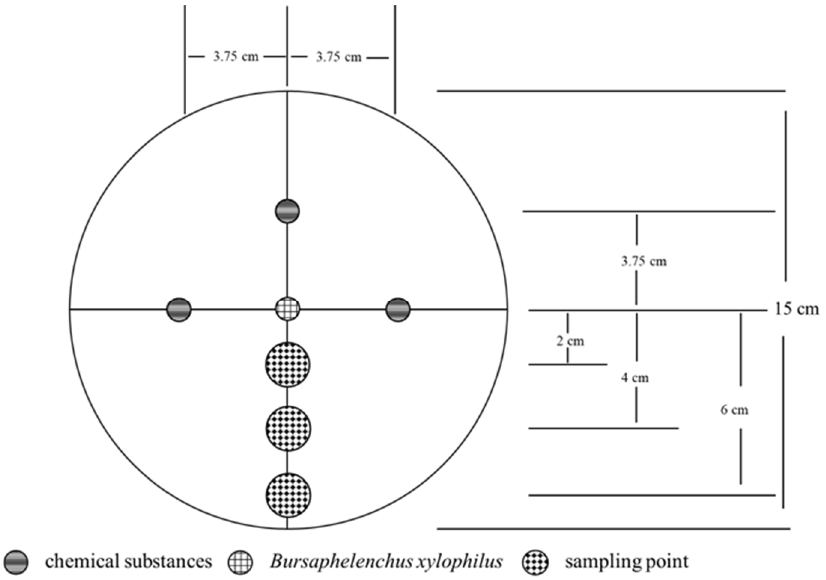
Figure 2. Schematic diagram of the plate repellency experiment.